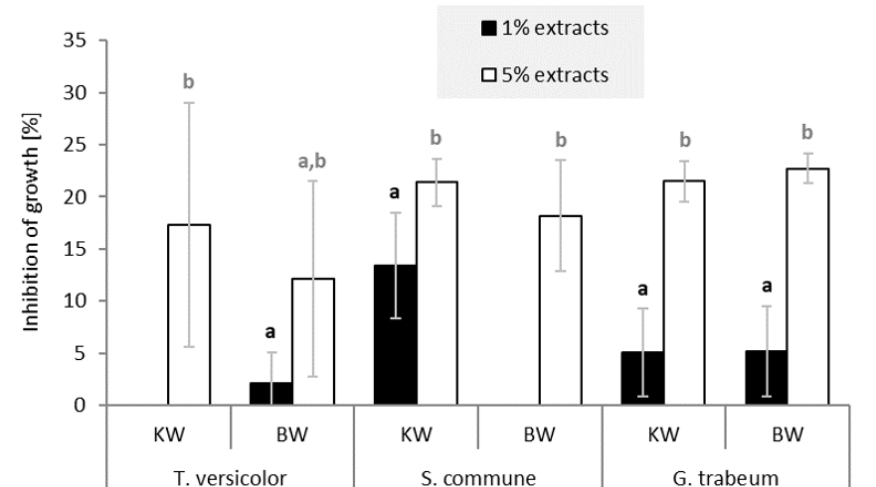
Figure 6. Growth inhibition of the white-rot fungi Trametes versicolor and Schizophyllum commune , and the brown-rot fungus Gloeophyllum trabeum by crude hydrophilic extracts of silver fir ( Abies alba ). The columns represent the average inhibition achieved with 1% and 5% solutions (DMSO, w/v ) of knotwood (KW) and branchwood (BW) extracts. a,b Different letters on the error bars of the same series of columns indicate statistically significant differences at a 95% confidence level (LSD test).